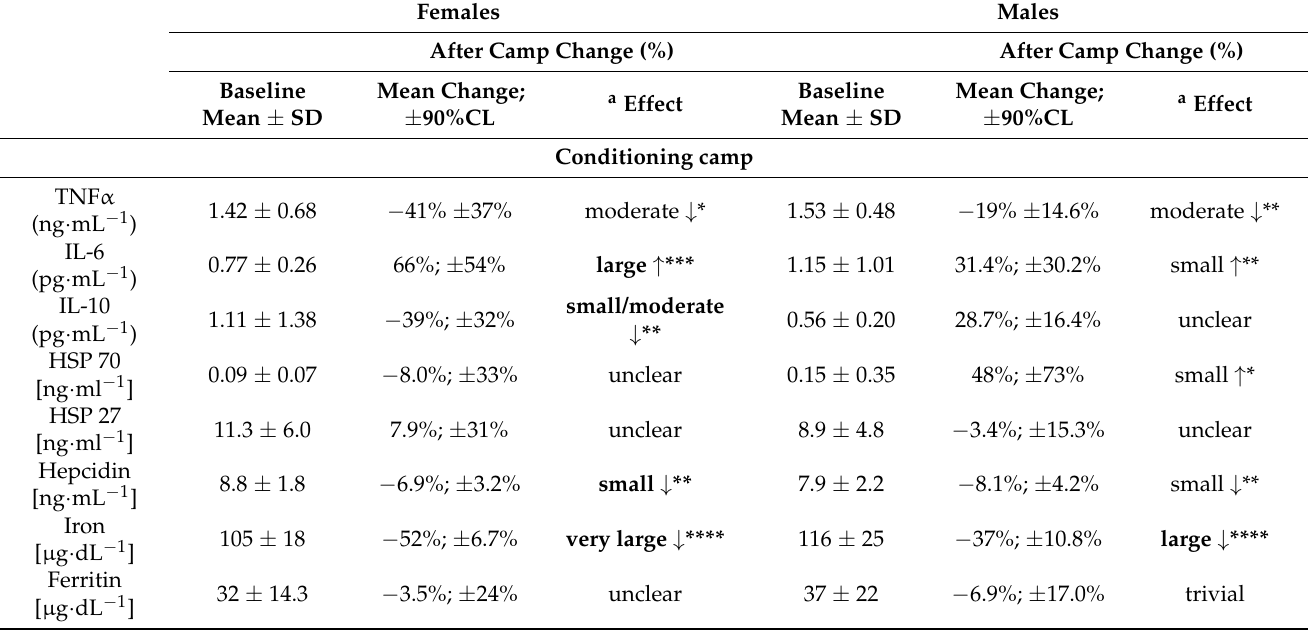
Table 3. Immunological responses induced by physical workload after both camps in female (n = 12) and male (n = 14) youth